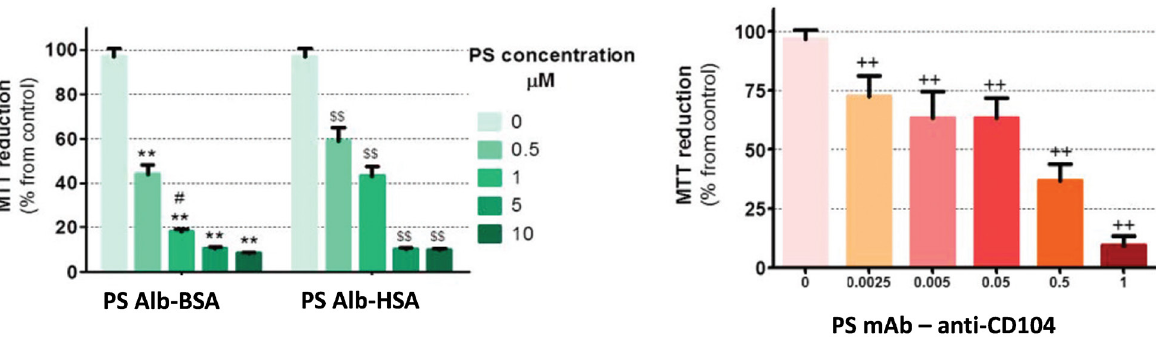
Figure 22 - Phototoxicity Ps Alb conjugates and PS mAb - anti-CD104 immunoconjugate in UM-UC-3 cells. This cell line was incubated in the dark with the compounds at different concentrations or with PBS (control) for 4 h and irradiated for 40 min. The cell survival fractions were determined 24 h after treatment by the MTT colorimetric assay. There is no significant reduction of MTT in UM-UC-3 cells treated with non-conjugated Por 1–PDT (p < 0.05) in relation to the control. There are significant differences in the MTT reduction of Por 1–albumins/–mAb anti-CD104 when compared with the control. The MTT reduction produced by Por 1–BSA at 1 μM is statistically different when compared with the one for Por 1–HSA. **Significantly different from Por 1–BSA at 0 μM (p < 0.05), $$ Significantly different from Por 1–HSA at 0 μM (p < 0.05), # significantly different from Por 1–HSA at the same concentration. ++ Significantly different from Por 1–mAb anti-CD104 at 0 μM (p < 0.05). The values are presented as mean ± standard deviation of 3 independent experiments (n=3), using the control as a reference value for cellular viability (100%). Reproduced from Pereira et al. 2014a with permission of The Royal Society of